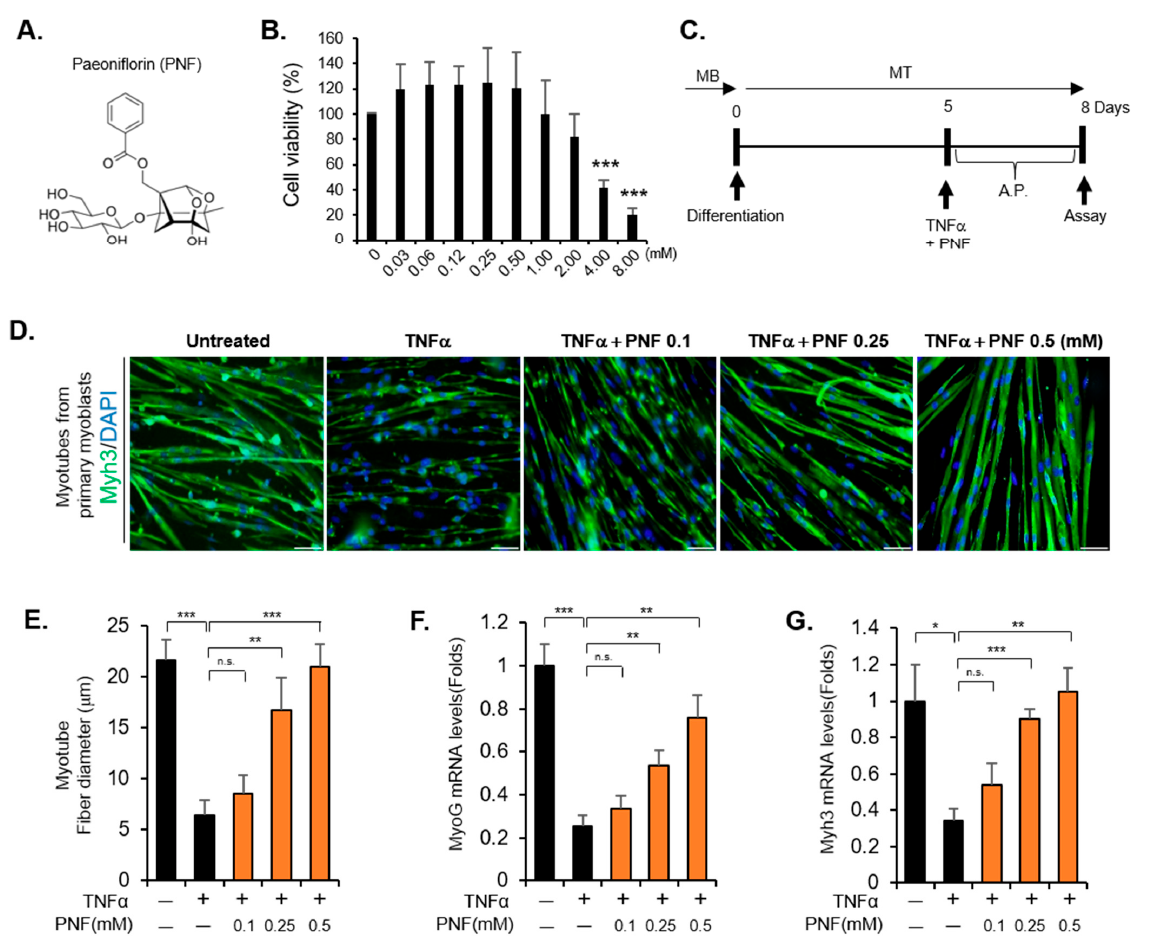
Figure 1. PNF improves TNF α -induced muscle atrophy in primary differentiated myoblasts and C2C12 cells: ( A ) Chemical structure of PNF. ( B ) Effects of PNF on the viability of differentiated C2C12 cells treated with the indicated concentrations for 72 h. ( n = 3). ( C ) Schematic representation of the in vitro experimental protocol with atrophied muscle. ( D ) Primary differentiated muscles were stained with Myh3. DAPI indicates the nucleus. The concentration of TNF α used was 10 ng/mL, and that of PNF was 0.1, 0.25, and 0.5 mM. Scale bar: 100 µ m. ( E ) Quantitation of 200-myotube